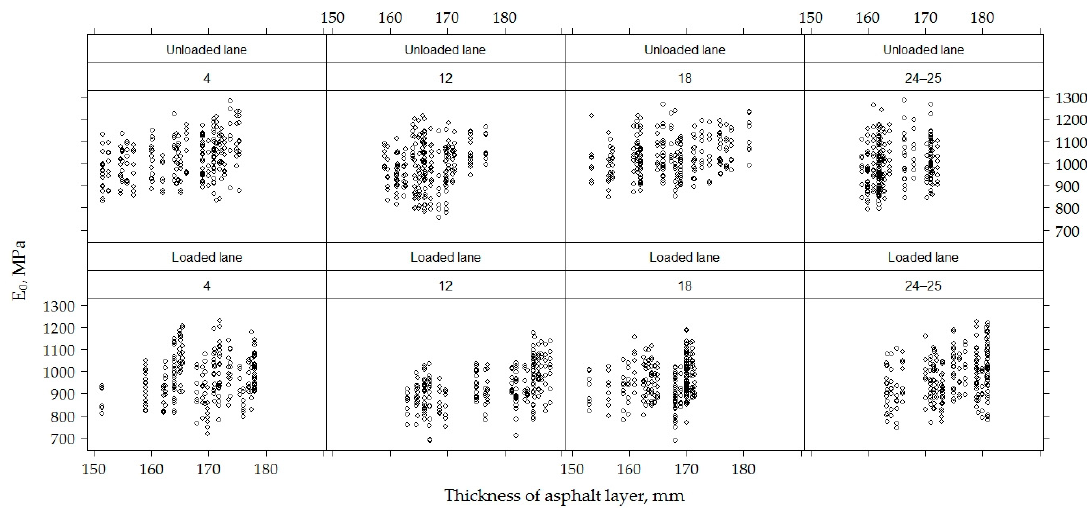
Figure 22. Influence of the total thickness of asphalt concrete layers on E 0 by analyzing each section individually in loaded and unloaded lanes.